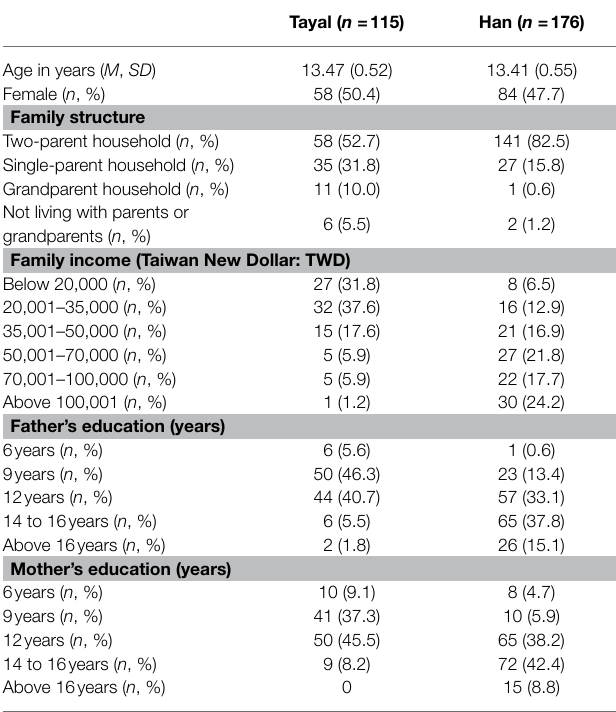
TABLE 1 | Demographic information of the Tayal and Han